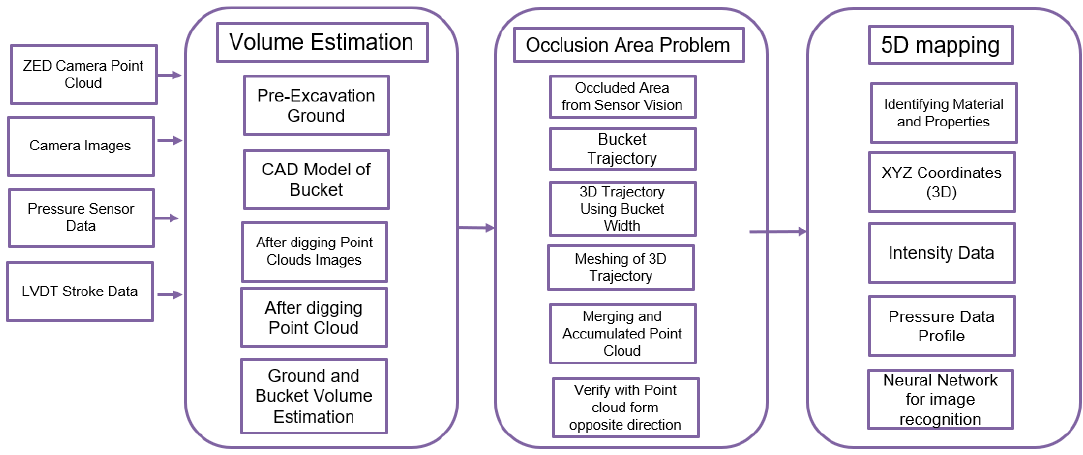
Figure 1. Integrative solution for monitoring autonomous excavation progress.